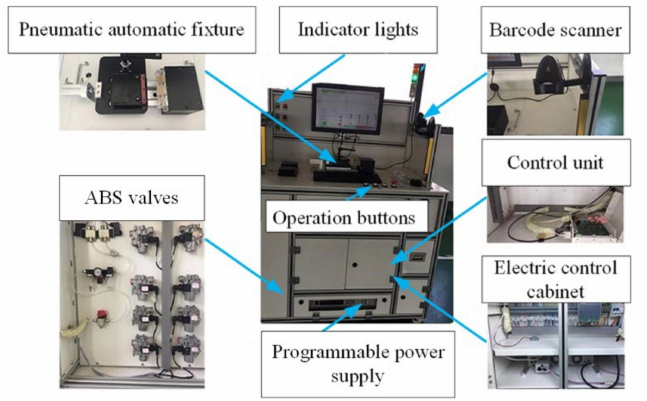
Figure 10. The prototype of the EOL test system for a pneumatic ABS